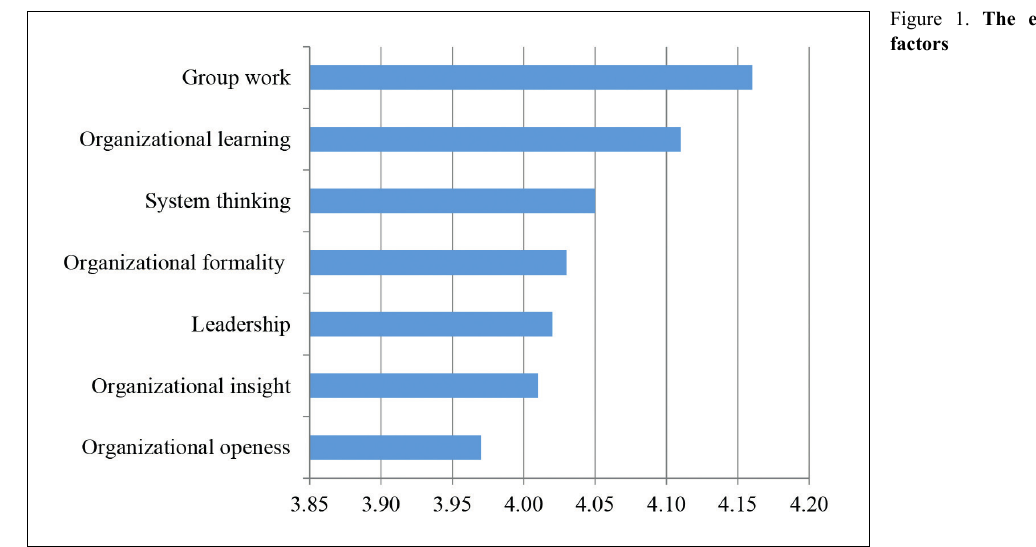
Figure 1. The evaluation of OI